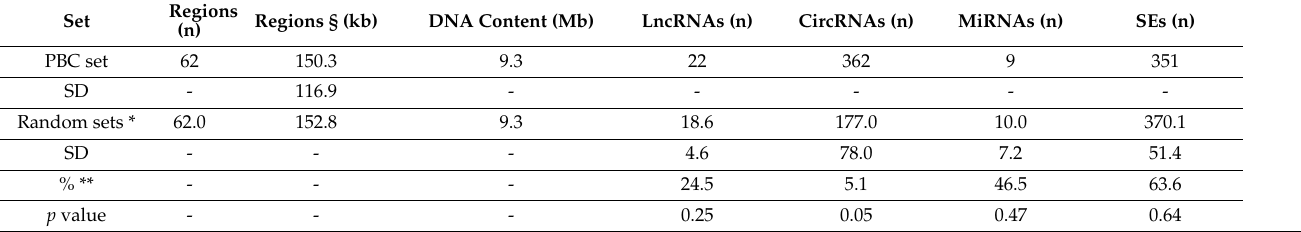
Table 3. Enrichment in non-coding elements in